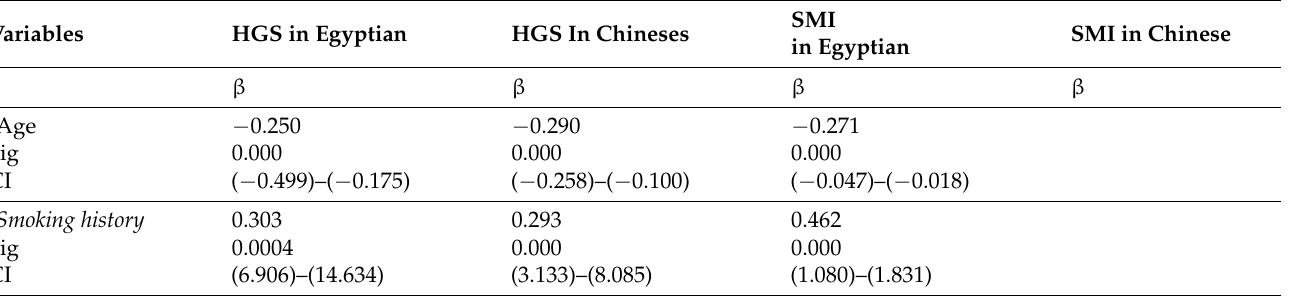
Table 4. The multivariate regression stepwise analysis results to identify pre- and post-stroke variables of possible sarcopenia and sarcopenia in both